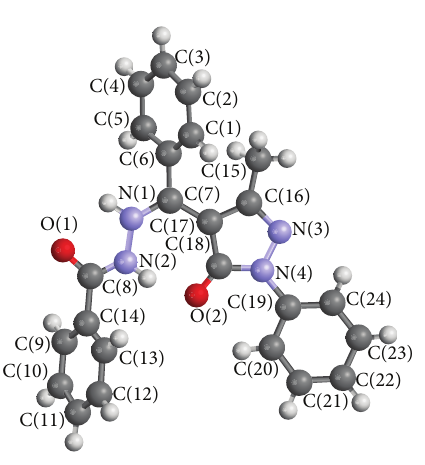
Figure 2: Molecular structure of HL 1 showing the atom numbering scheme with thermal ellipsoids at the 50% probability